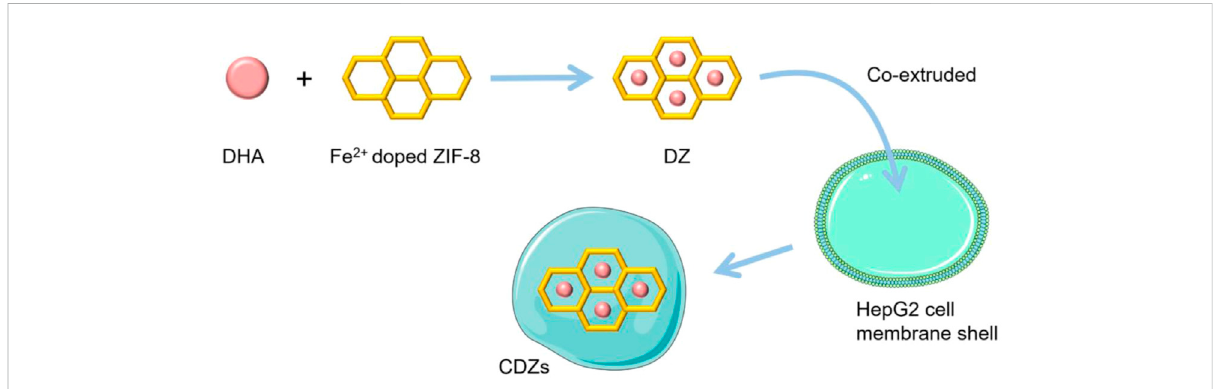
FIGURE 4 Synthesis and application of CDZs. The schematic pieces were provided by Smart Medical Art and adapted [http://www.servier.com]. Servier Medical Art by Servier is licensed under a Creative Commons Attribution 3.0 Unported